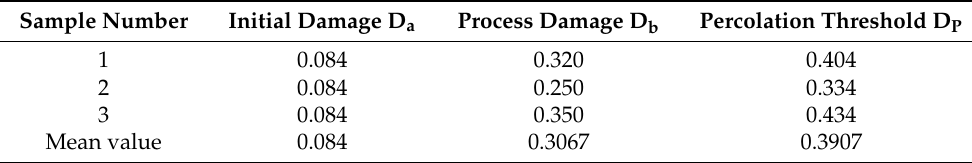
Figure 8. Comparison of stress–strain curves of test results and those predicted by the damage model. Table 2. Damage and percolation threshold of rock